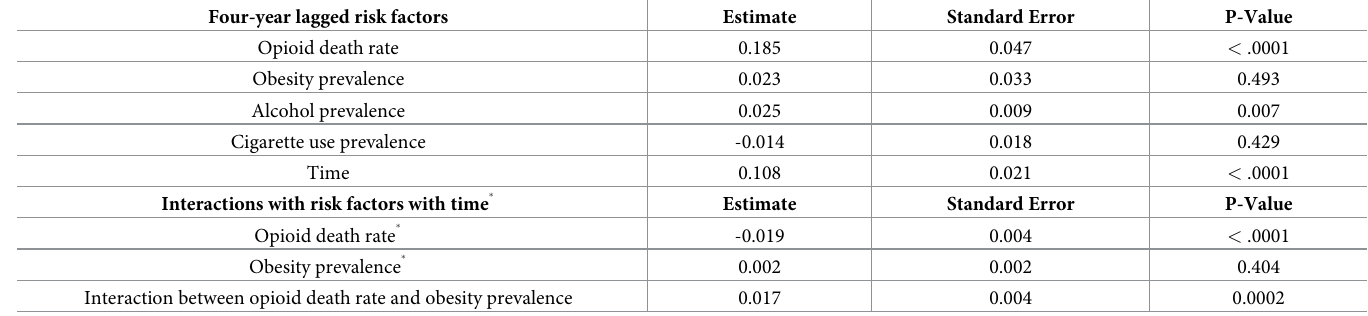
Table 2. Mixed effects regression model analysis results using risk factors with a four year delay to account for the development of pro-cancerous